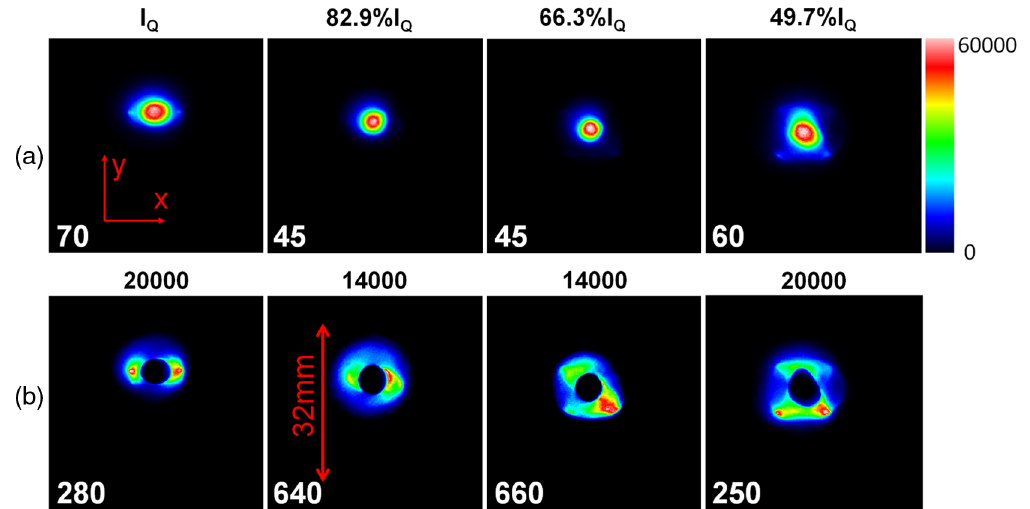
FIG. 18. Comparison of core and halo with changing quadrupole strength; (a) unmasked beam picture; (b) masked beam